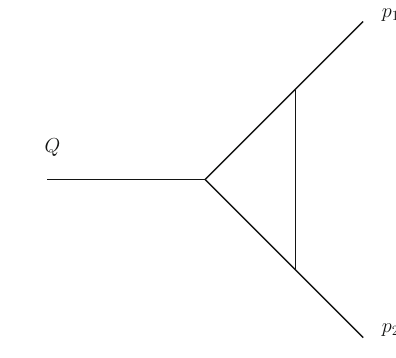
Fig. 4 A one loop triangular